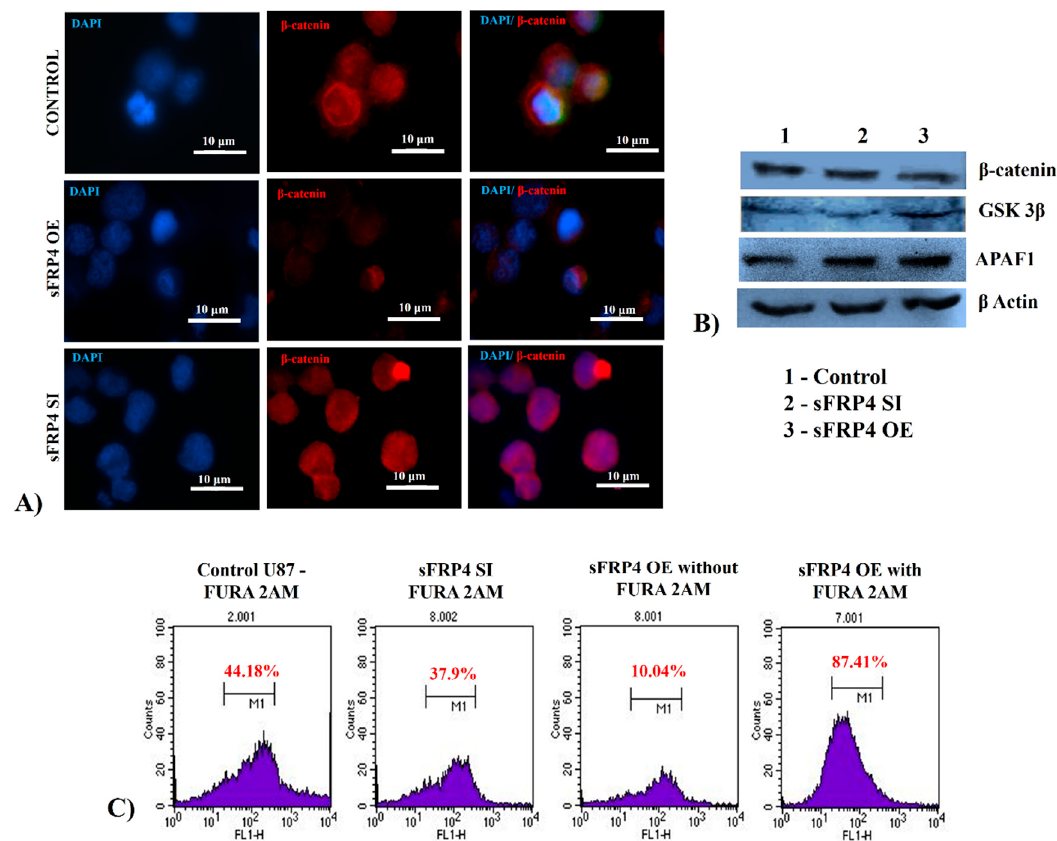
Figure 4. Analysis of intracellular components of Wnt pathway displayed downregulation of Wnt canonical pathway regulators in sFRP4 OE. There was a decrease in β -catenin as shown by immunocytochemical staining of β -catenin (red) in sFRP4 OE cells while there was an increase in nuclear β -catenin in sFRP4 SI cells (scale bar = 10 µm) ( A ). Western blot analysis showed a decrease in β -catenin and increase of GSK3 β and APAF1 in sFRP4 OE cells ( B ), FURA-2AM analysis by flow cytometry showed an increase in intracellular calcium level in sFRP4 OE compared to sFRP4 SI cells ( C